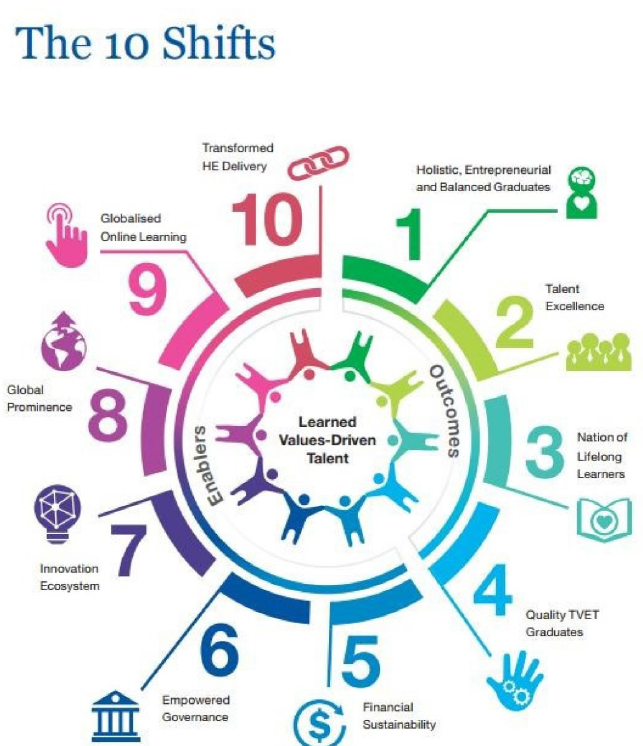
Figure 1. The 10 shifts in Malaysia Education Blueprint (Higher Education) (Ministry of Education Malaysia, 2015)